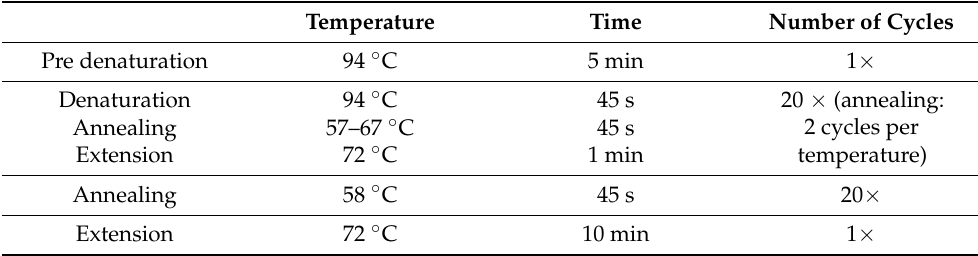
Table 2. The touchdown PCR cycle procedure in this